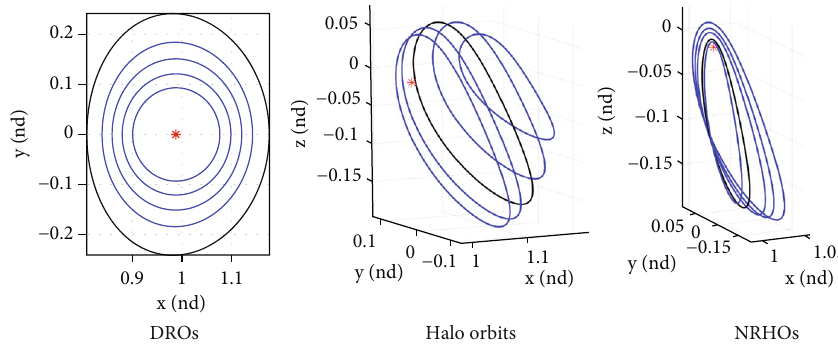
Figure 2: The nominal orbits in the CR3BP.